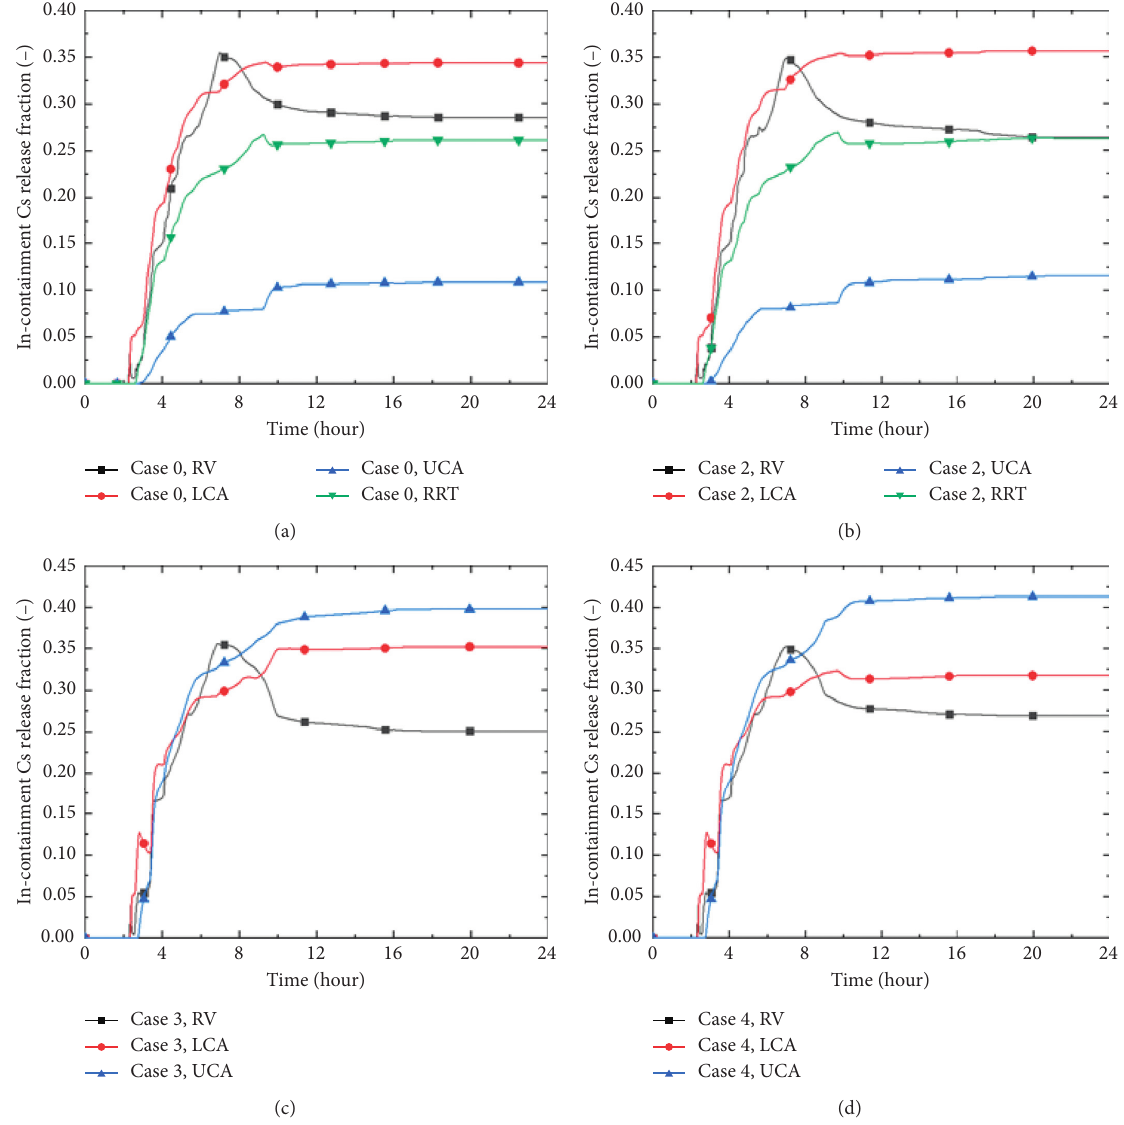
Figure 12: In-containment cesium release fractions: (a) case 0, (b) case 2, (c) case 3, and (d) case